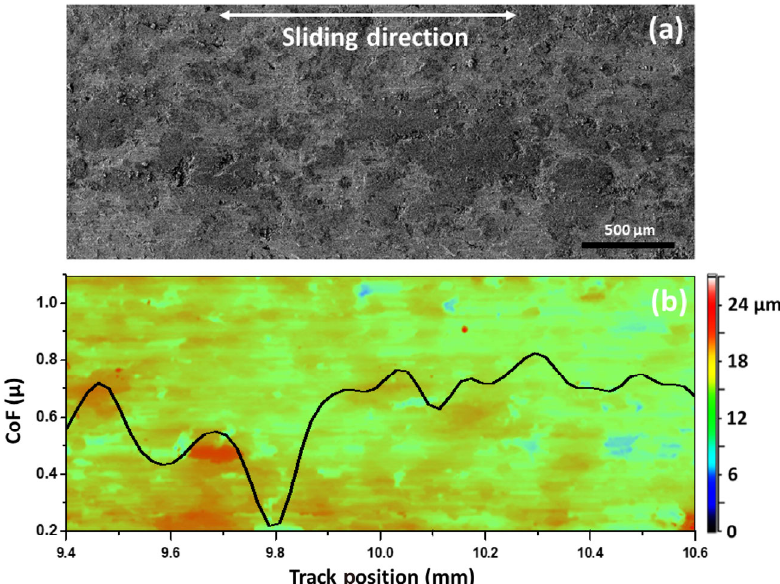
Fig. 9 Instantaneous CoF with surface profilometry indicating lower average CoF at the position where steel substrate is absent. (a) SE image of wear track and (b) surface profilometry of the same segment with overlapped CoF.